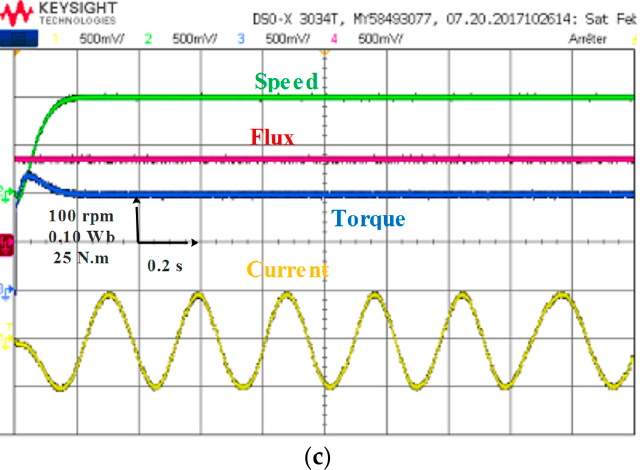
Figure 26. Steady-state analysis at low speed with different techniques ( a ) DTC; ( b ) FDTC; ( c ) MPDTC.